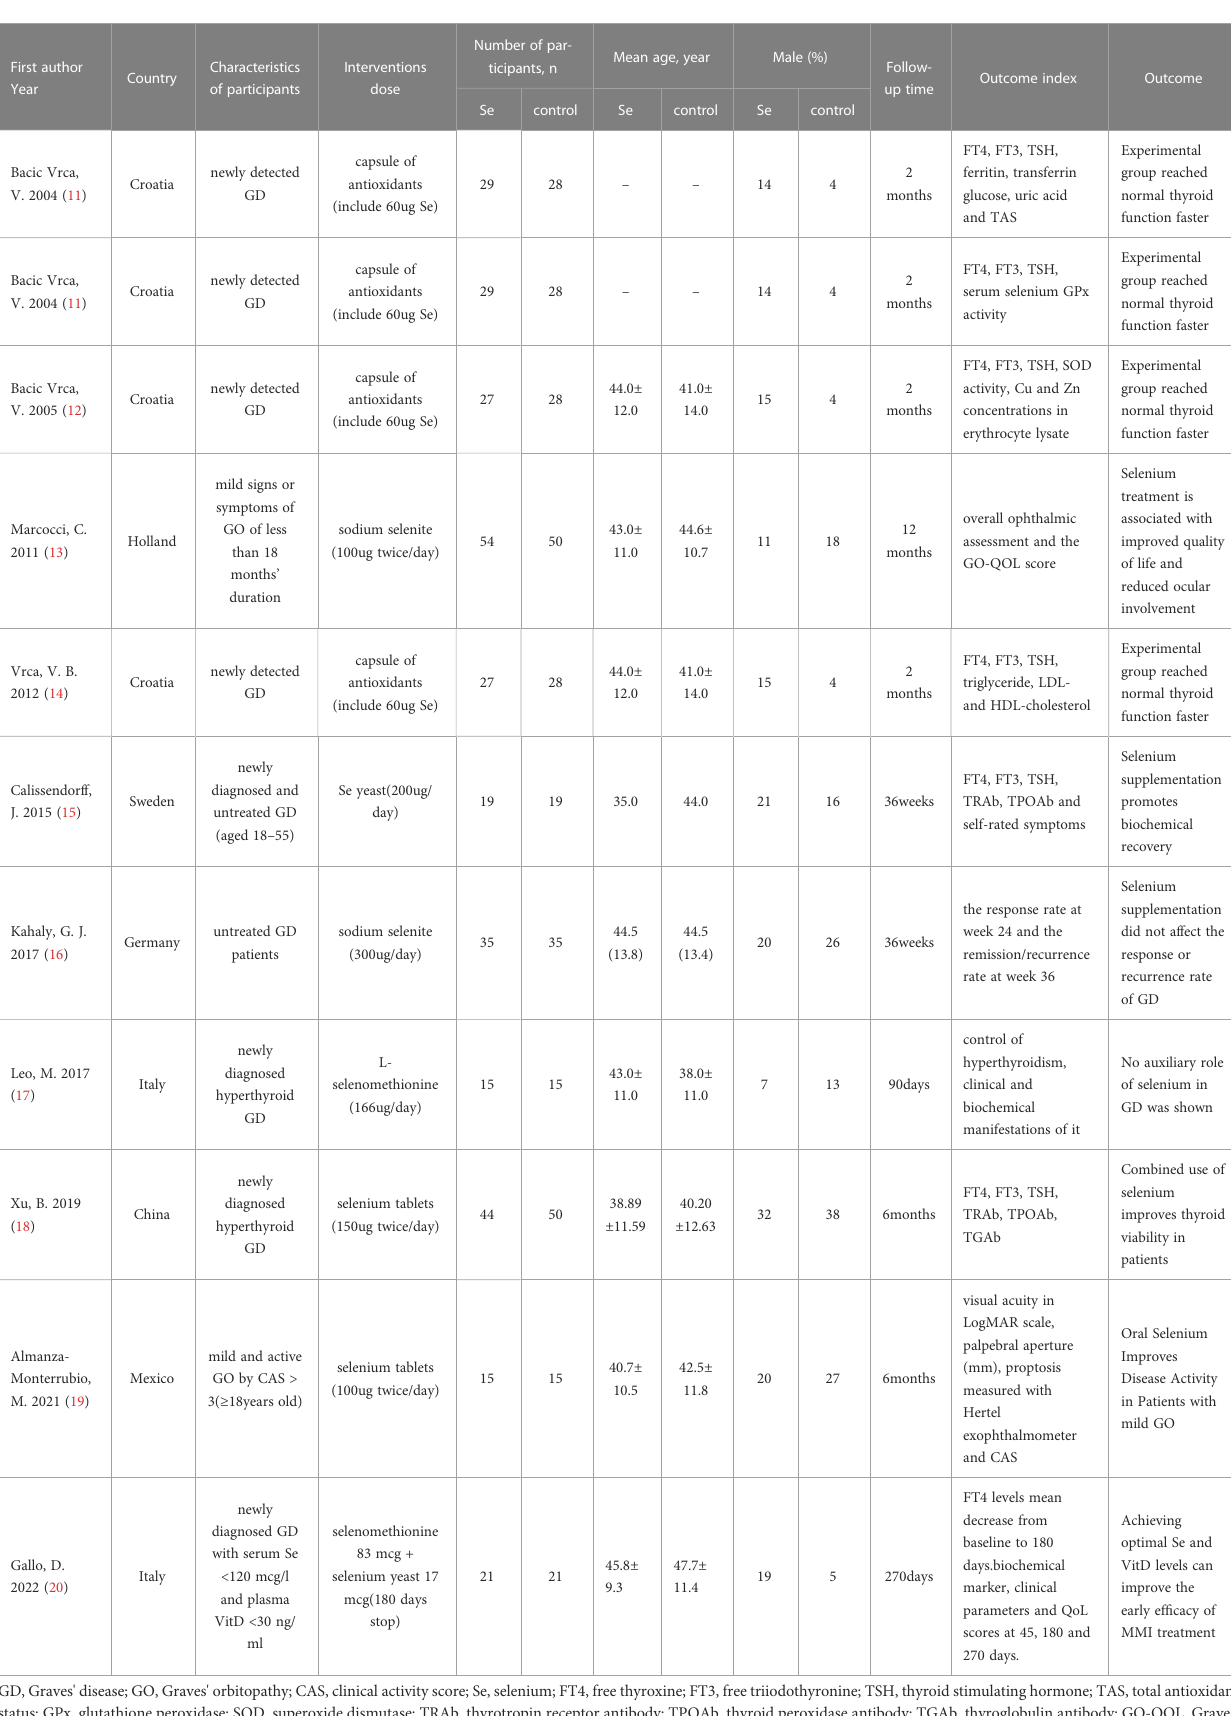
TABLE 1 Characteristics of 11 included studies.